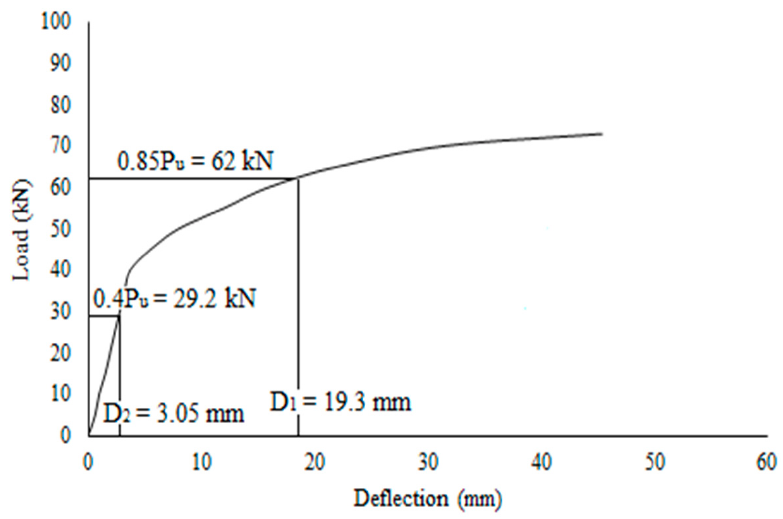
Figure 19. Ductility ratio for trapezoidal profiled composite slab.